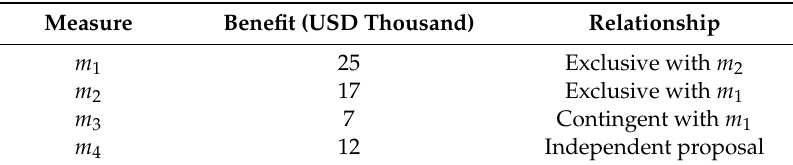
Table 1. Benefit and relationship of flood measures.